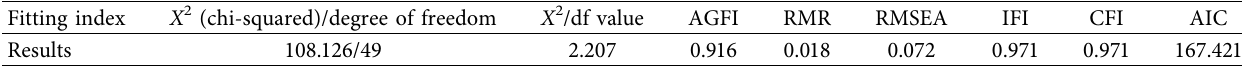
Figure 5: Optimized structural equation model for public satisfaction with ICH digital display. Table 8: Common fitness indices.